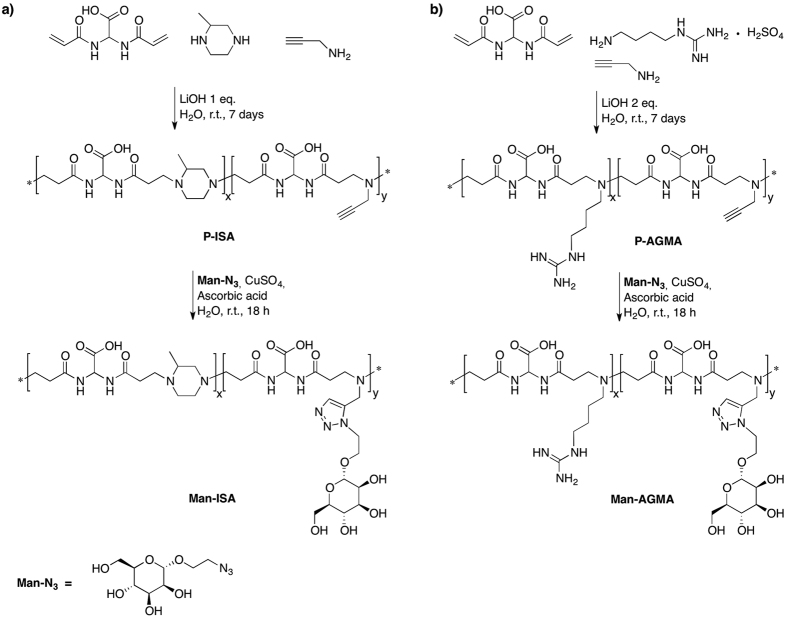
Synthesis of (a) Man-ISA and (b) Man-AGMA polymers. Two batches of each polymer were prepared with different content of propargylamine bearing repeating units: P-ISA7 and P-ISA14 (7.0 and 14.0%); P-AGMA6.5 and P-AGMA14.5 (6.5 and 14.5%). The corresponding mannosylated polymers had the same mannosyl unit content.